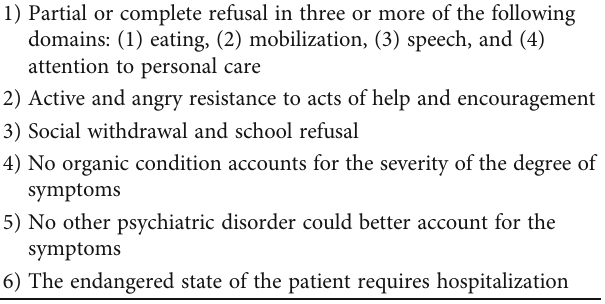
Table 1: Diagnostic criteria for PRS as adapted by Jaspers et al.